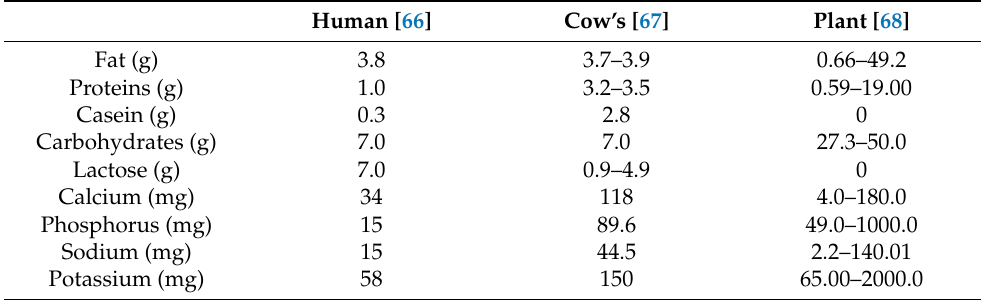
Table 3. Content of nutrients in 100 g of human, cow and plant milk.